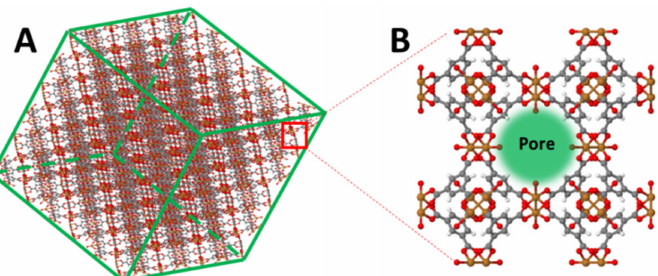
Figure 1. ( A ) 3D structure of HKUST-1 metal–organic frameworks. ( B ) Pore channel (green sphere) within a metal-organic framework (MOF)’s unit cell (red: oxygen, orange: metal and grey: carbon). The structural figures were modified from the ChemTube 3D